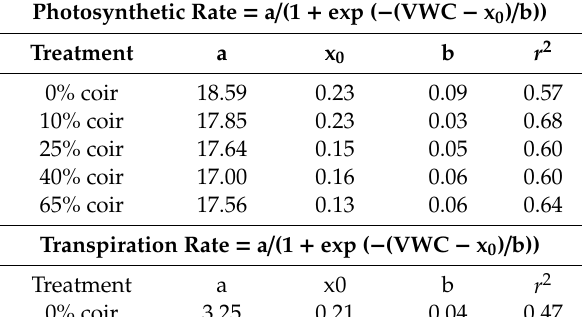
Table 2. Fit model parameters for the relationship between plant gas exchange, weight, and substrate volumetric water content (VWC) for Hydrangea paniculata ‘Jane’ (Little Lime ® hardy hydrangea) grown in a pine bark substrate amended with 0%, 10%, 25%, 40% or 65% of coir by volume. The models’ r 2 are provided in the last column of the